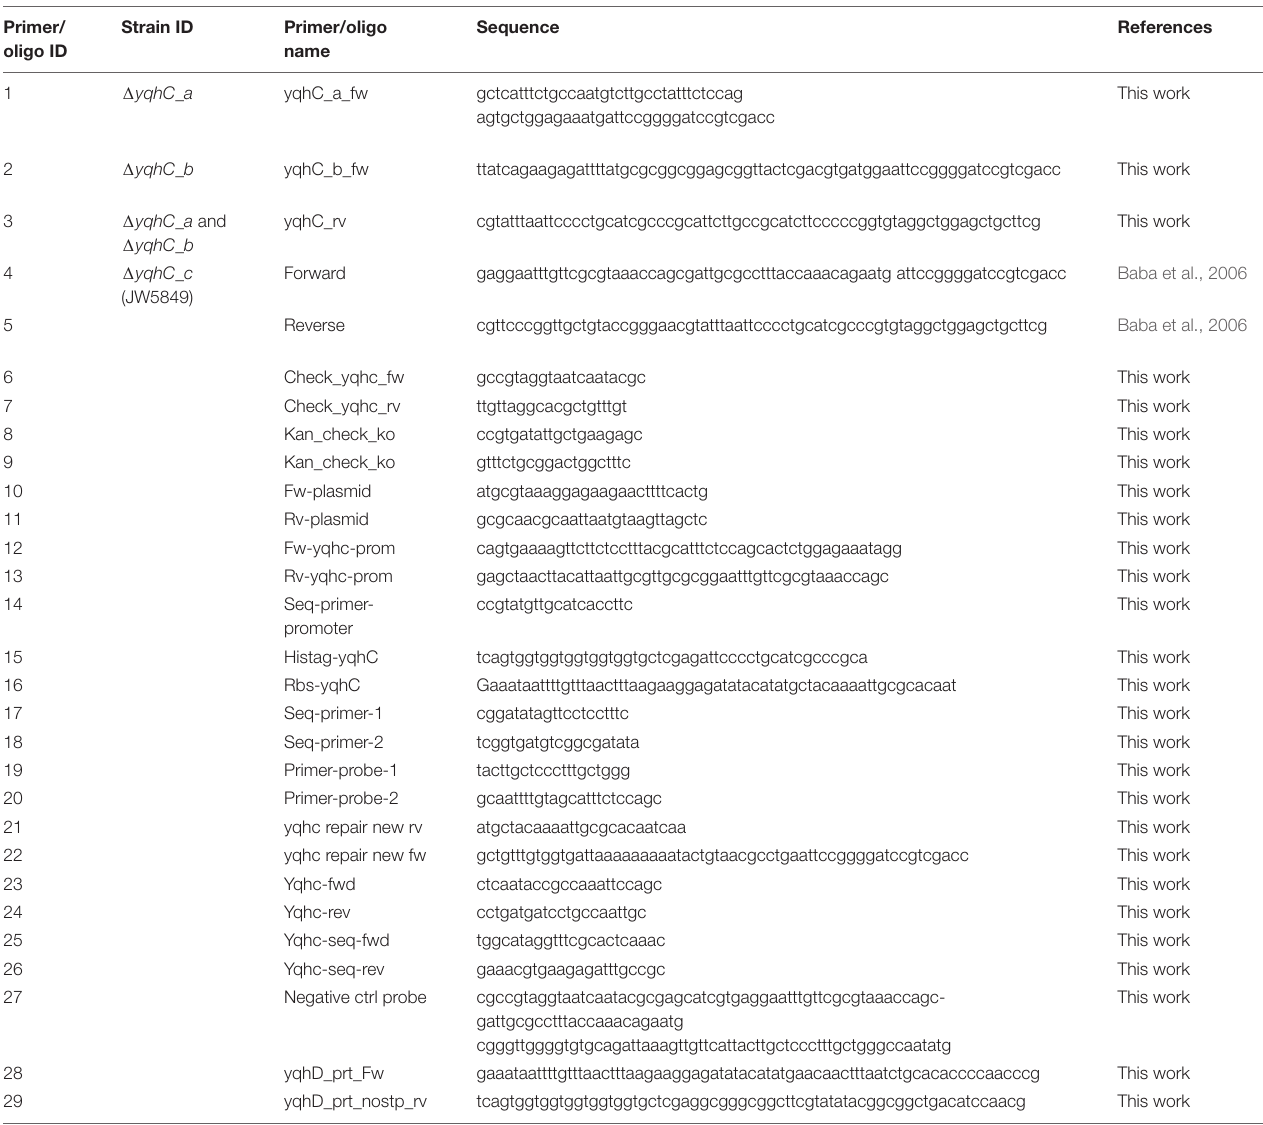
TABLE 2 | Primers and oligos used in this